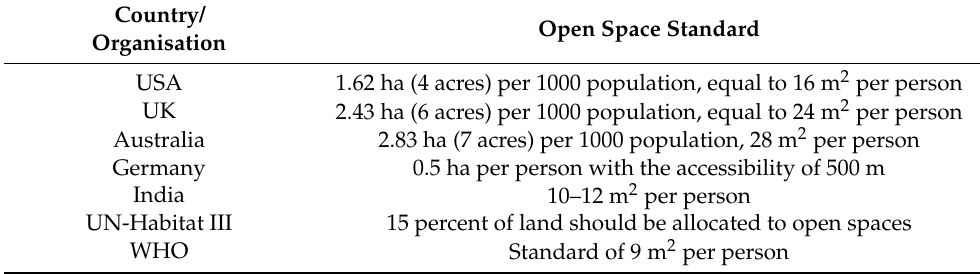
Table 2. Open Space